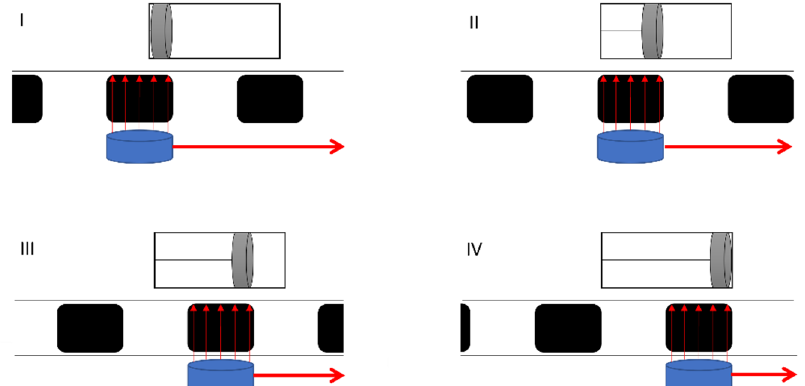
Figure 1. Analogy between slug flow and a piston pump. Each slug corresponds to a new piston. ( I ) Ferrofluid starts to accelerate; ( II ) Ferrofluid reached maximum acceleration; ( III ) Ferrofluid starts to decelerate; ( IV ) Ferrofluid stops accelerating but moves due to existing inertia.